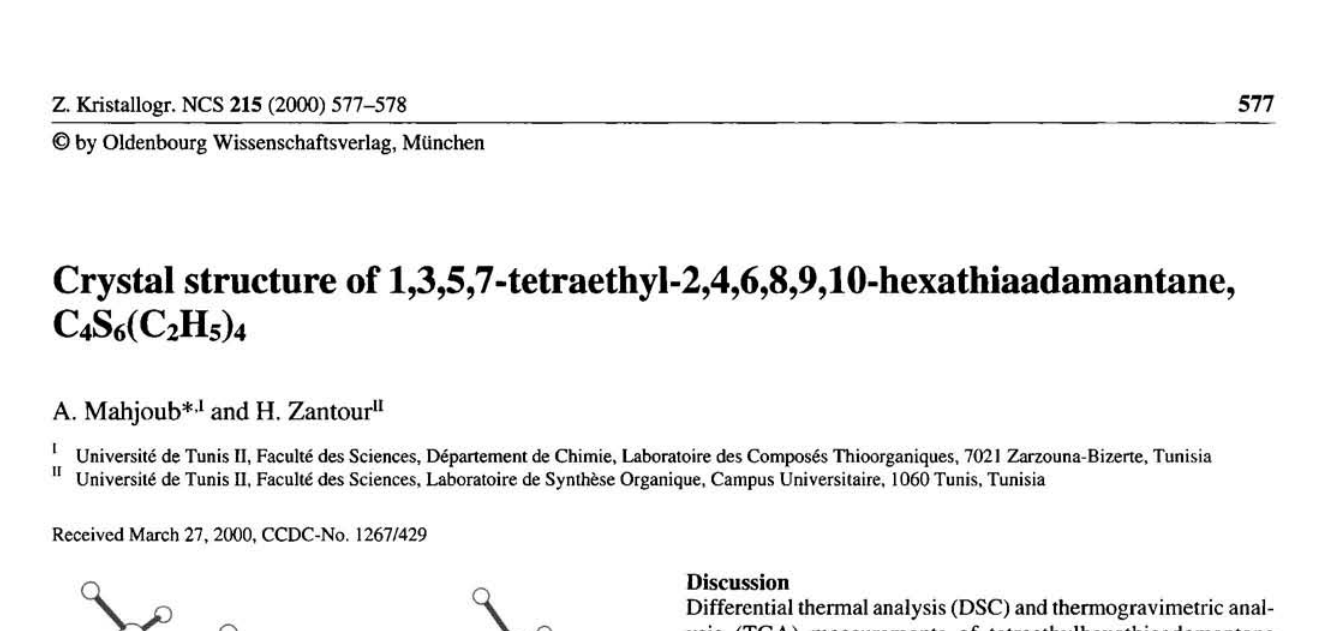
Table 1. Data collection and handling.